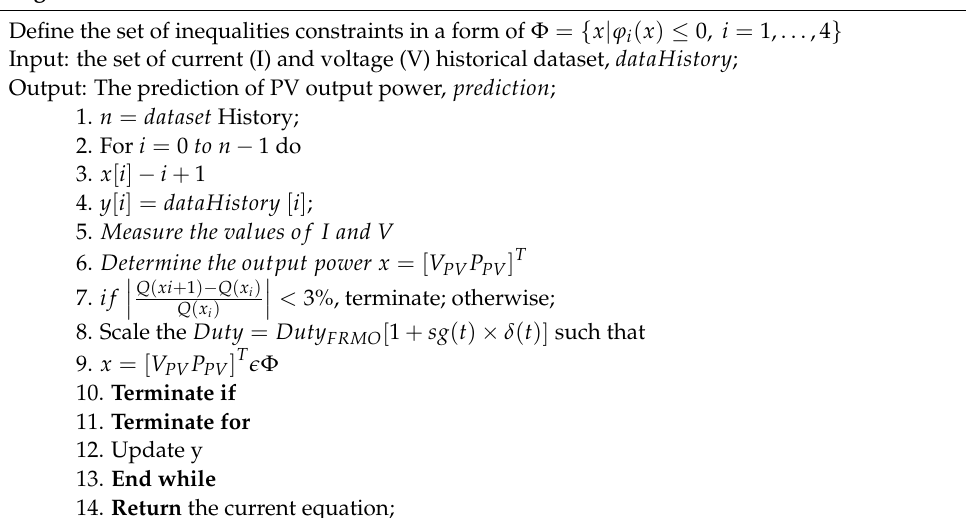
Algorithm 1. Pseudo-code of